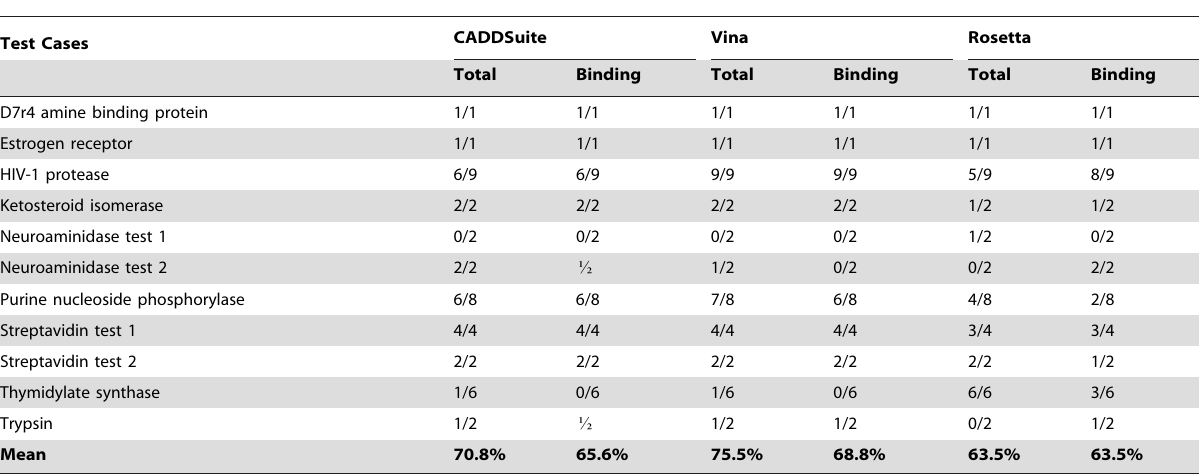
Table 2. Order of designs by predicted binding